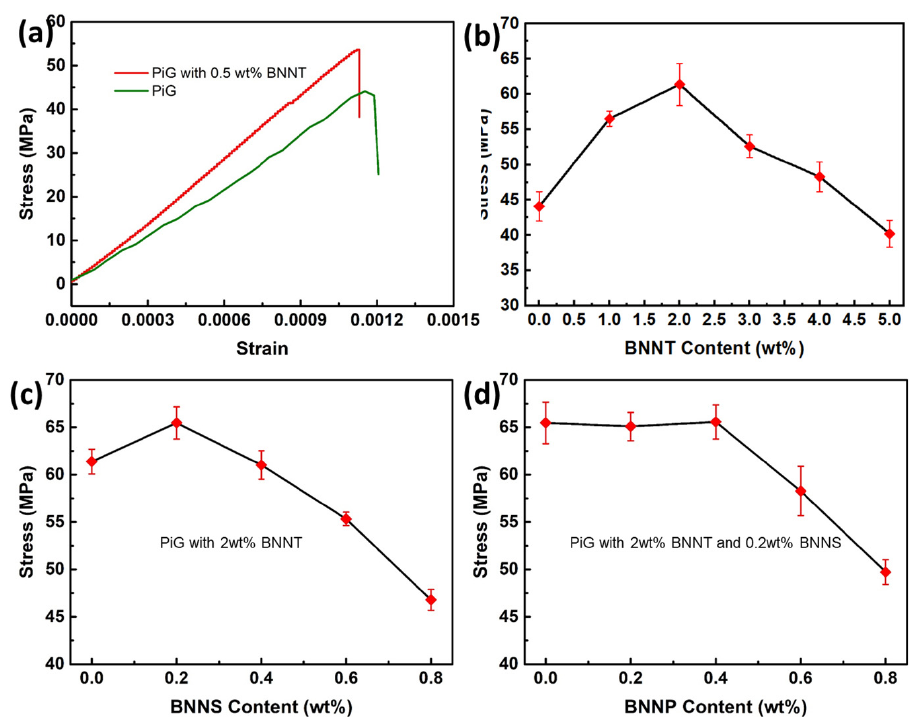
Figure 8. ( a ) Stress-strain curves of PiG and the one with 0.5 wt% BNNT; ( b – d ) Flexural strength of PiGs with di ff erent content of BNNT, BNNS and BNNP.